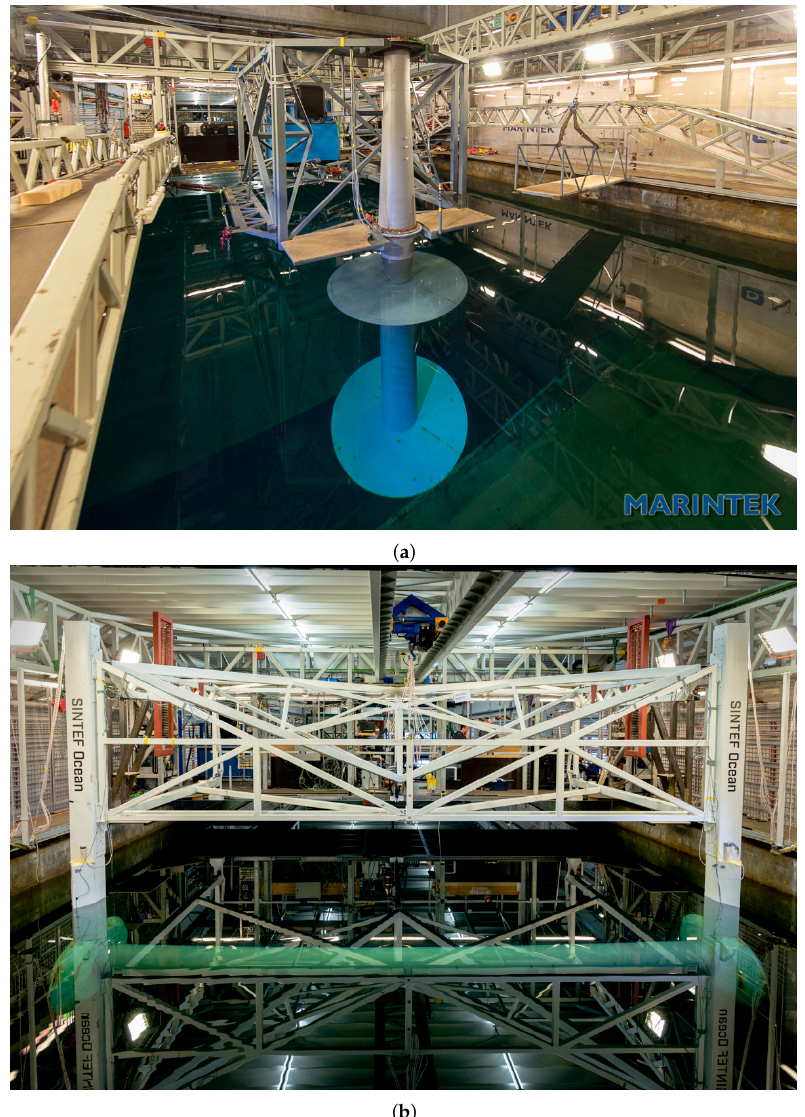
Figure 11. Full-scale VIV model test set-up at SINTEF Ocean [22,68]. ( a ) Vertical set-up [22]. ( b ) Hori- zontal set-up